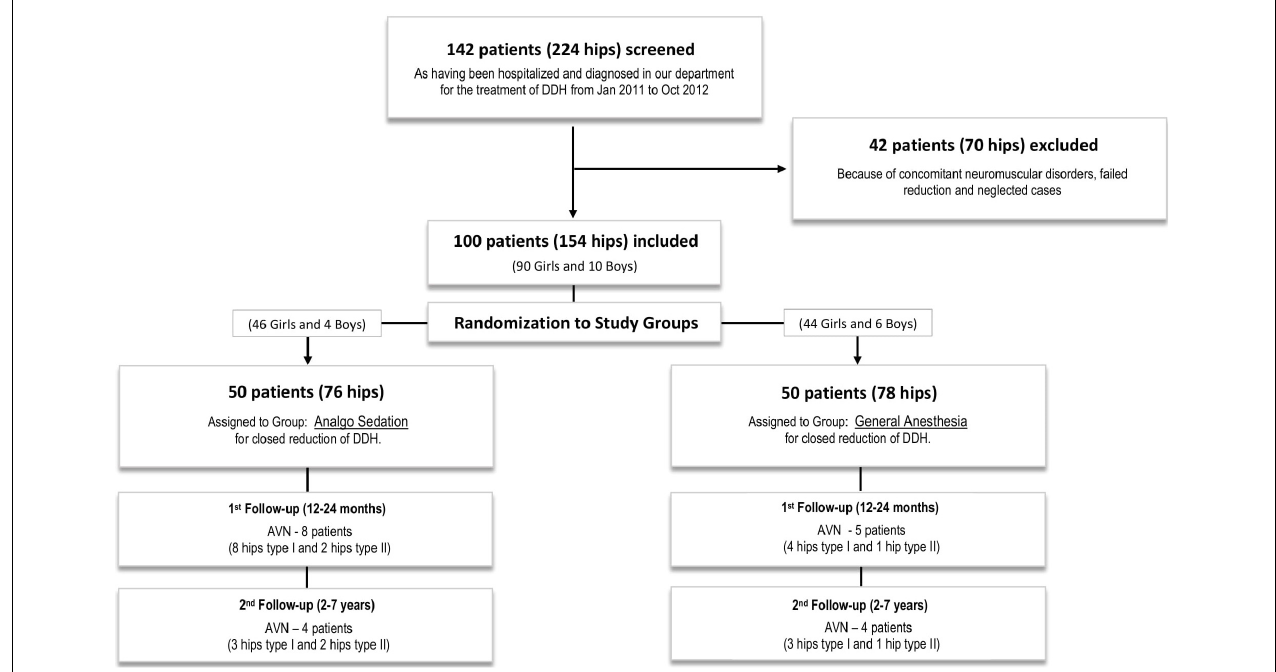
FIGURE 2 | The CONSORT flowchart shows the selection and randomization of the study subjects in two different groups of the clinical trial.